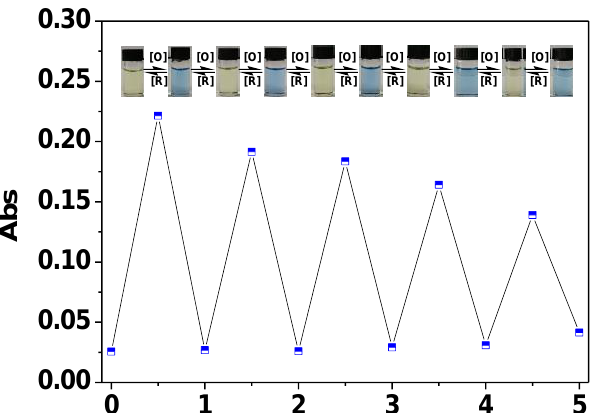
Figure 6. UV-vis absorption spectra changes at 619 nm of L-ol (10 µ M) in PBS aqueous bu ff er (DMF:PBS = 7:3, 20 mM, pH = 7.4) upon the alternate addition of HOCl / GSH with several concentration ratios (0:0, 20:0, 20:50, 40:50, 40:100, 60:100, 80:100, 80:150, 100:150, 120:150 and 120:200 µ M, respectively). [O], oxidation; [R], reduction.